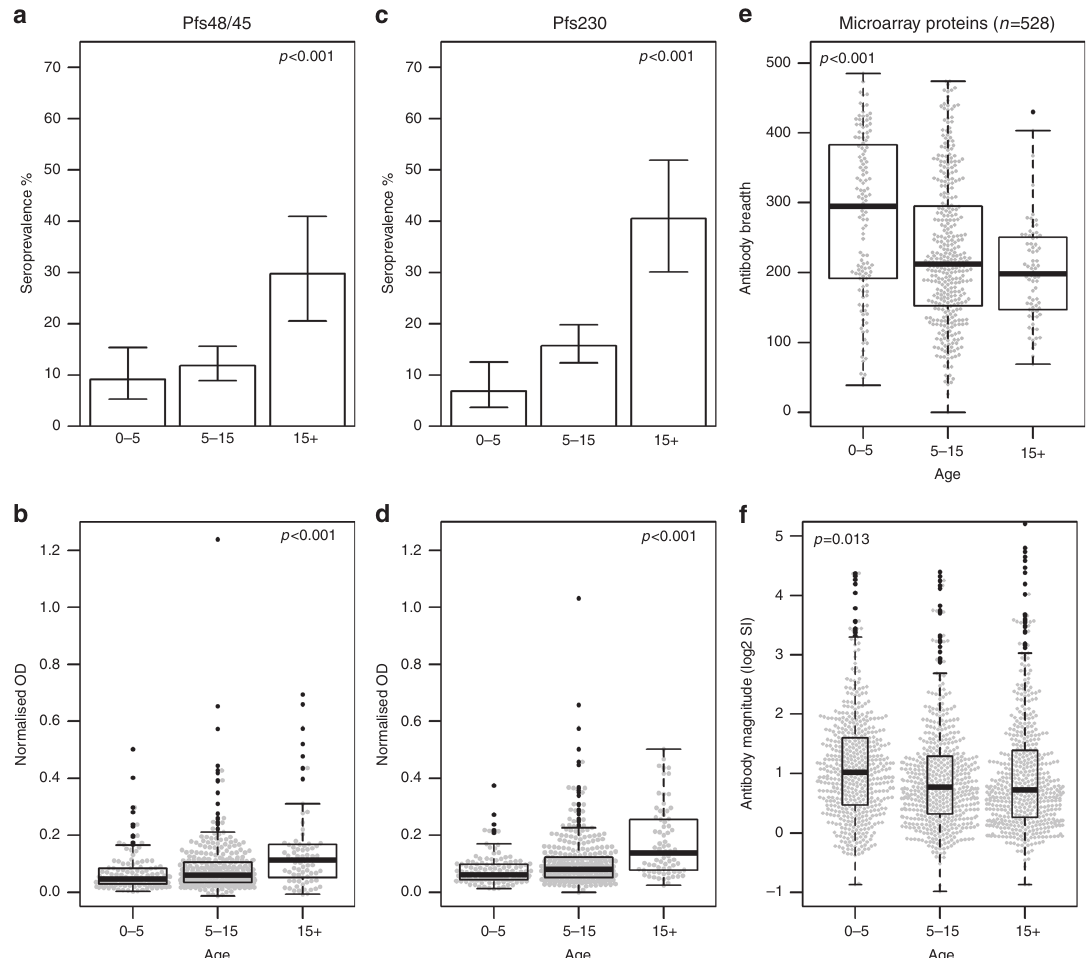
Fig. 1 Antibody responses to Pfs48/45, Pfs230 and to the microarray proteins with age. Antibody responses to correctly folded, recombinant Pfs48/45- 10C and Pfs230 (230CMB) were measured using ELISA, with antibody intensity given as the ELISA optical density (OD) values (450 nm). Antibody responses to microarray proteins are given as the log 2 -transformed signal intensity (SI) minus the vehicle SI, which equates to the log 2 -fold change over this background. All graphs show only individuals from endemic areas (Dutch migrants excluded). Sample size: 0 – 5 = 131, 5 – 15 = 366, 15+ = 71. a , c Bars show the seroprevalence of α -Pfs48/45 and α -Pfs230 antibodies with age, with Clopper – Pearson con fi dence intervals. b , d Boxplots showing α -Pfs48/45 and α -Pfs230 antibody intensity with age. e Boxplots showing responses to the microarray protein targets ( n = 528). Antibody breadth is the number of proteins reactive above background in each individual, within the given groups. f Magnitude of antibody response to microarray protein targets. Each dot represents the average SI of response to each protein target by all individuals within given groups. p -values for prevalence data are from likelihood ratio test for differences in seroprevalence between all age groups, derived from logistic regression and adjusted for gametocyte density. p -values for intensity data and response breadth are from an F- test for differences in OD/SI between all age groups, derived from linear regression and adjusted for gametocyte density or from ANOVA (for magnitude only). For all boxplots, outliers are shown in black, whereas all data points are shown in grey as a